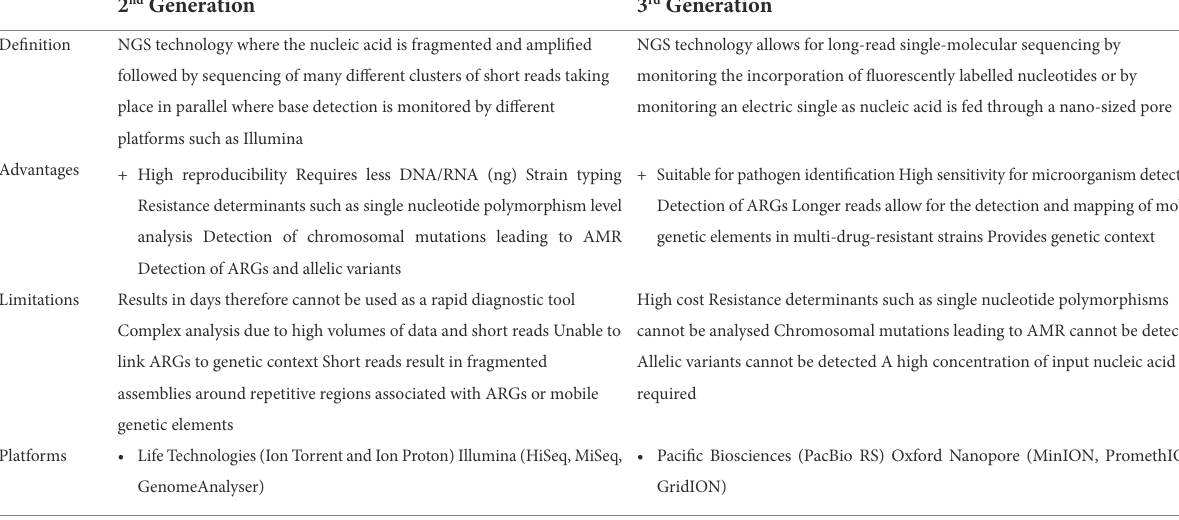
TABLE 1 Second-generation versus third-generation sequencing technologies for antibiotic susceptibility testing. 2 nd